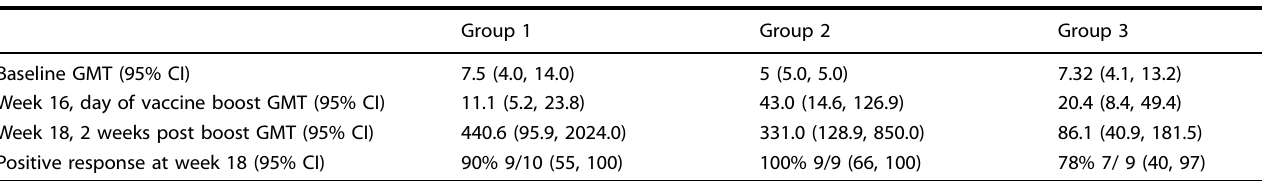
Table 2. Neutralizing antibody responses by group assignment